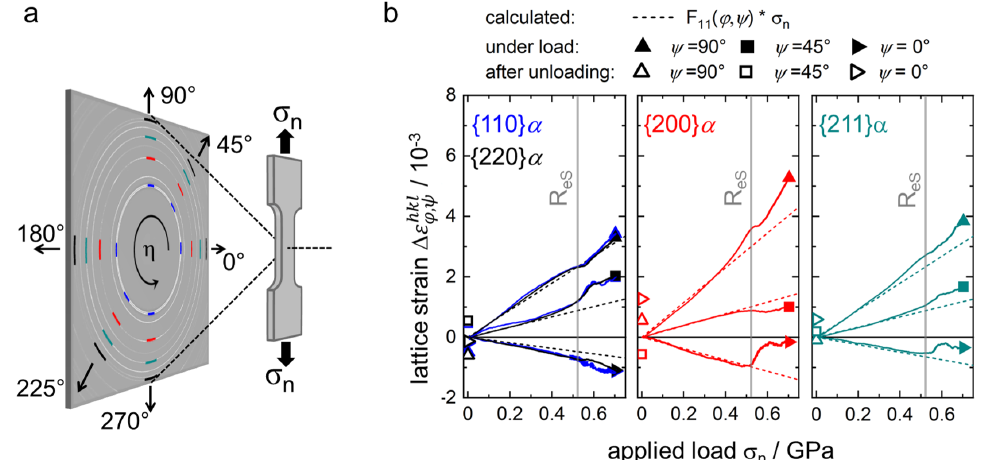
Figure 7. Debye–Scherrer rings of the ferritic phase ( α ) of the DSS ( a ); Lattice strain vs. applied load for three selected directions ψ = η = 0 ◦ , ψ = η = 45 ◦ and ψ = η = 90 ◦ experimentally determined (solid lines) and calculated (dotted lines) for lattice planes { 110 } α , { 200 } α , { 221 } α and { 220 } α ( b ). The unfilled symbols indicate the residual strain after unloading. It can be seen that for both phases, the introduced intergranular strains also remain in the unloaded